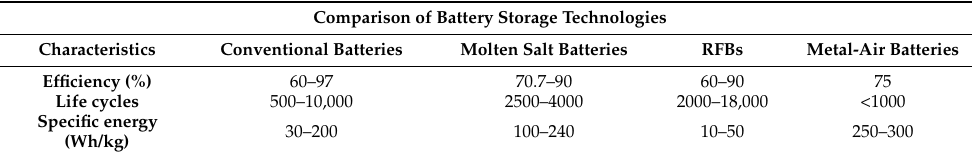
Table 10. Summary of the technical parameters of the batteries studied in the paper. Comparison of Battery Storage